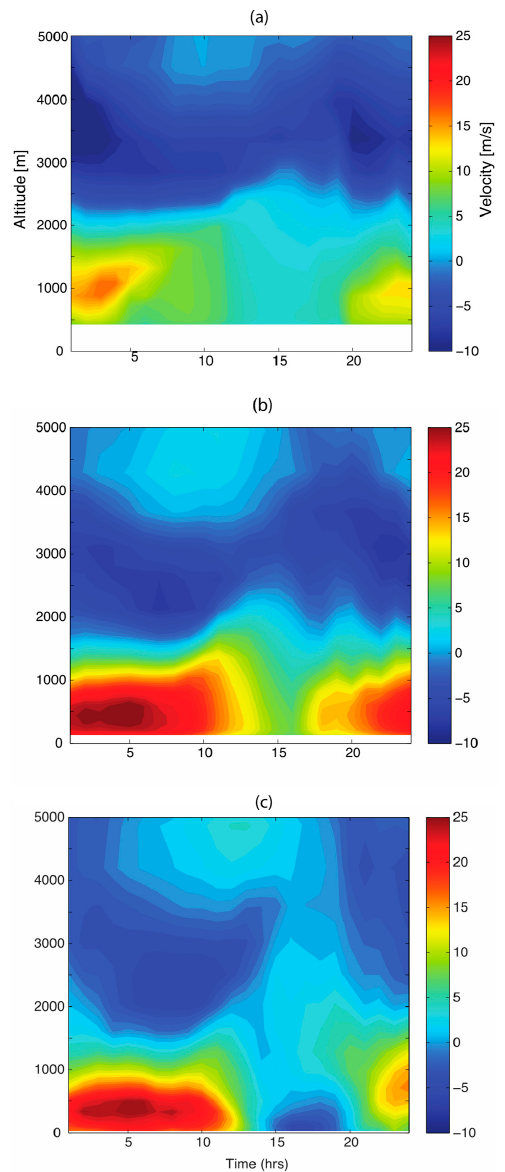
Figure 4. Hovmöller diagrams for the 12 July 2008 event. Shown is the along-thalweg component of horizontal velocity vs. time and elevation above the mean sea level at ( a ) the head of the northern spillway; ( b ) in the narrowest portion of the gap; and ( c ) out over the Red Sea. The locations of the stations are indicated by stars in Figure 1, with ( a ) lying close to point a’ , ( b ) lying just northeast of D , and ( c ) lying near E . Time is UTC (local Saudi time minus 3 h). The upper boundaries of the white space at the bottoms of the panels indicates the elevation of the land.